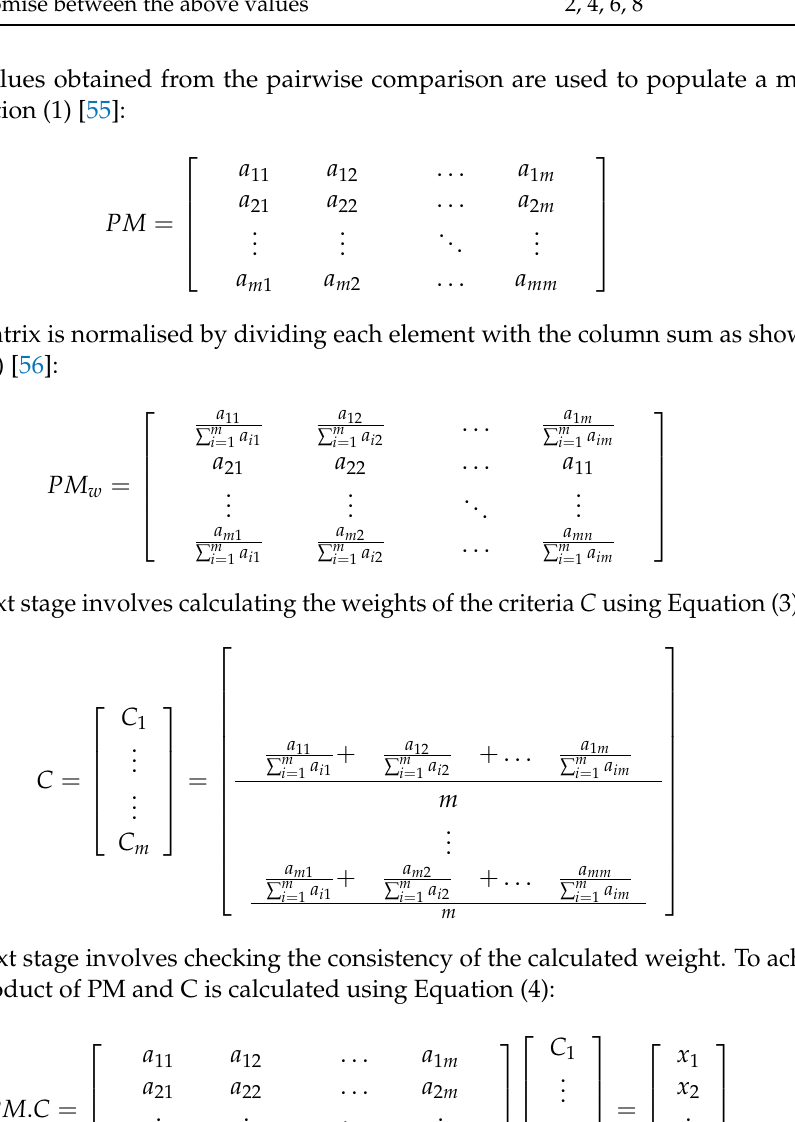
Table 4. Pairwise comparison scale, data from [56] Level of Importance Rating Extreme Importance 9 Very Strong Importance Strong Importance Moderate Importance Equal Importance Compromise between the above